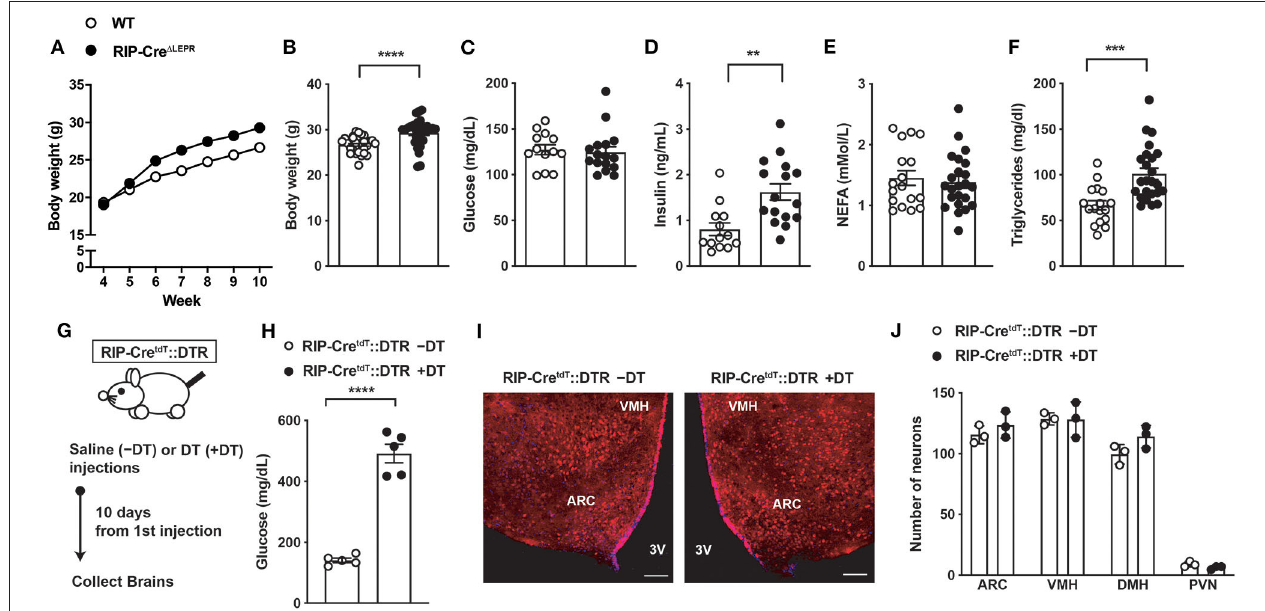
FIGURE 1 | Induction of insulin deficiency with a RIP-DTR approach does not affect RIP-Cre 25Mgn neurons. (A) The time course of body weight ( n = 33; WT and 30; RIP-Cre 1 LEPR ), (B) body weight ( n = 33; WT and 30; RIP-Cre 1 LEPR ), (C) blood glucose ( n = 13; WT and 16; RIP-Cre 1 LEPR ), (D) plasma insulin ( n = 13; WT and 16; RIP-Cre 1 LEPR ), (E) plasma NEFA ( n = 17; WT and 23; RIP-Cre 1 LEPR ), (F) plasma TG ( n = 17; WT and 24; RIP-Cre 1 LEPR ) in mice lacking LEPRs in RIP-Cre 25Mgn neurons (RIP-Cre 1 LEPR ) at 10 weeks of ages. Wild type control (WT) were homozygous Lepr flox without RIP-Cre 25Mgn transgene. (G) A schematic design for experiments for H, I, and J. Mice were i.p., administered with DT (3 times [0, 1, 2 days], 0.5 µ g/kg B.W.) (H) Blood glucose levels ( n = 5; RIP-Cre 1 LEPR –DT and 5; RIP-Cre 1 LEPR + DT), (I) representative figures (left; Saline injection, right; DT injections, white bar represents 100 µ m) and (J) the number of tdTomato positive cells in the hypothalamus 10 days after the induction of insulin deficiency in RIP-Cre 1 LEPR mice expressing tdTomato in RIP-Cre 25Mgn neurons by a RIP-DTR approach ( n = 3; RIP-Cre 1 LEPR –DT and 3; RIP-Cre 1 LEPR + DT). VMH, the ventromedial hypothalamic nucleus; ARC, the hypothalamic arcuate nucleus, 3V, third ventricular; DMH, dorsomedial hypothalamic nucleus; PVN, the paraventricular hypothalamic nucleus. Values are mean ± S.E.M. **** p < 0.0001, *** p < 0.001, ** p < 0.01. Unpaired t -test was used to analyze the